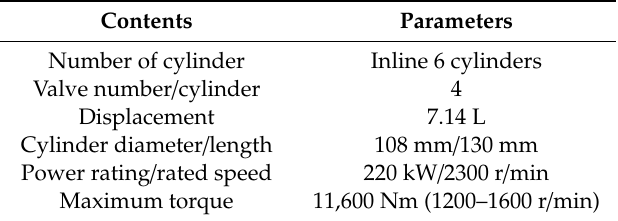
Figure 8. Fault simulation test diesel engine: ( a ) test diesel engine on bench and ( b ) position of vibration acceleration sensors. Table 3. Main parameters of a certain type of diesel engine.